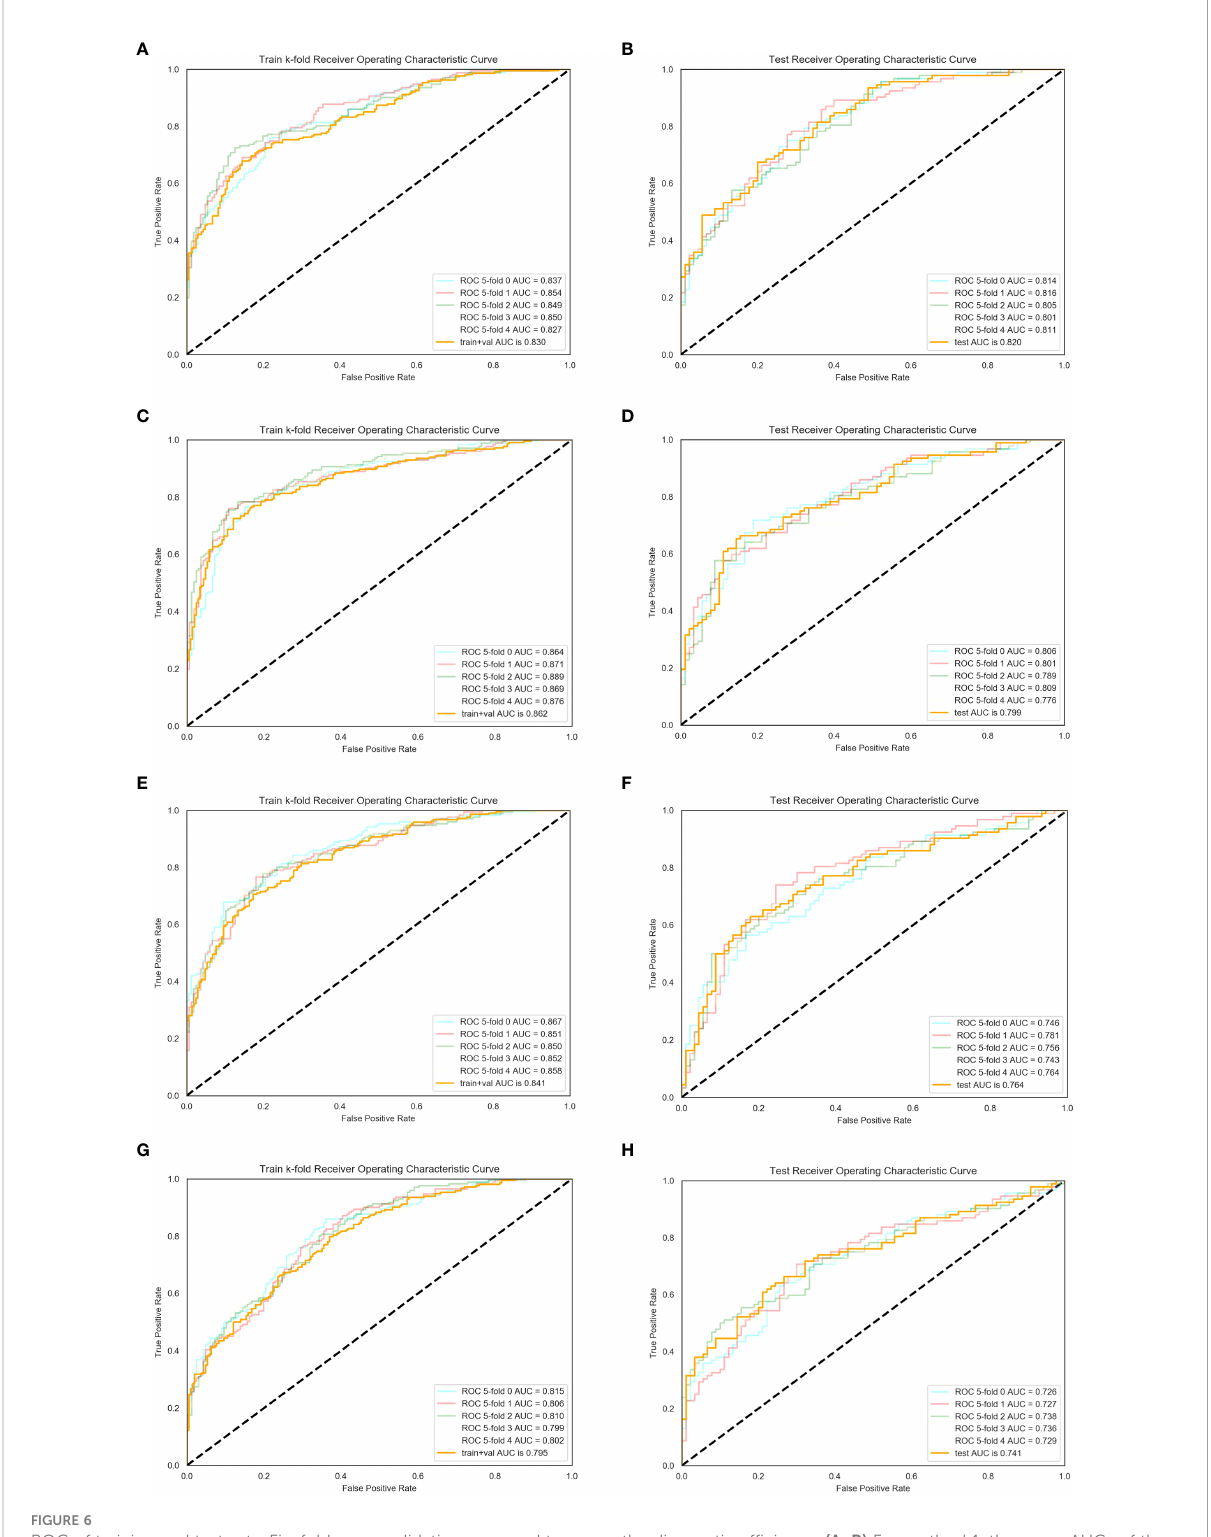
FIGURE 6 ROC of training and test sets. Fivefold cross-validation was used to assess the diagnostic ef fi ciency. (A, B) For method 1, the mean AUCs of the training and test set were 0.830 and 0.820, respectively. (C, D) For method 2, the mean AUCs of the training and test set were 0.862 and 0.7999, respectively. (E, F) For method 3, the mean AUCs of the training and test set were 0.841 and 0.764, respectively. (G, H) For method 4, the mean AUCs of the training and test set were 0.795 and 0.741,